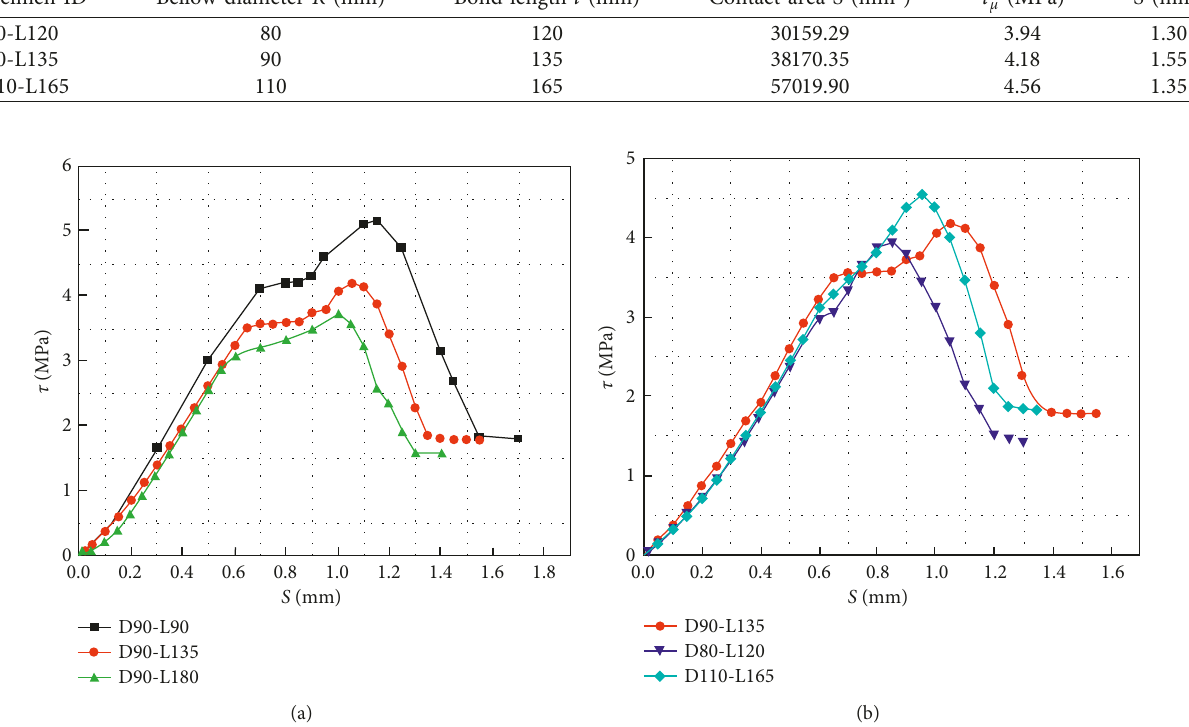
Figure 6: Bond-slip curves considering different (a) bond lengths and (b) contact